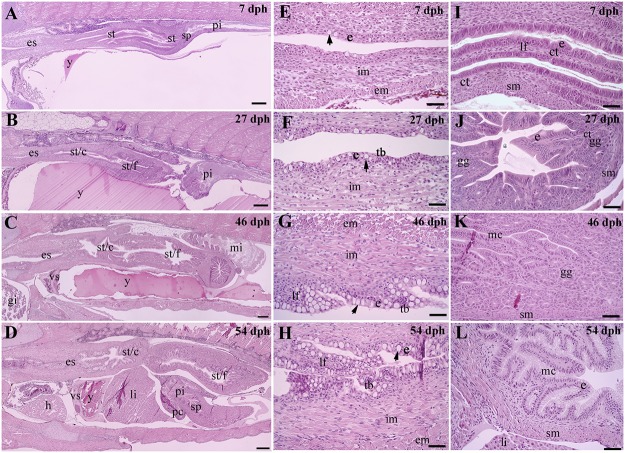
Representative sagittal sections of esophagus and stomach of Atlantic salmon juveniles at various time points (days post hatch [dph]).
(A-D) General overviews of esophagus and stomach at 7, 27, 46, and 54 dph; (E-H) Development of the esophagus: simple epithelium with stratified squamous cells and mucus cells (arrows) at 7 and 27 dph (E and F), presence of taste buds within the epithelium at 27, 46 and 54 dph (F-H), presence of longitudinal mucosal folds at 46 and 54 dph (G and H), and increasing numbers of mucus cells (arrows) and thickness of internal longitudinal and external circular striated muscle over the time; (I-L) Development of the stomach: longitudinal folded mucosal consisting of simple columnar epithelium and connective tissue at 7 dph (I), presence of incipient gastric gland devoid of pepsinogen granules (J), presence of abundant pepsinogen granules in oxynticopeptic cells of gastric glands at 46 dph (K), and cardic glands lined by mucus cells at 54 dph (L). Abbreviations: ct, connective tissue; e, epithelium; em, external circular striated muscle; es, esophagus; gg, gastric gland made up of pepsinogen granule-containing oxynticopeptic cells; h, heart; im, internal longitudinal striated muscle; lf, longitudinal fold; li, liver; mc, mucus cell; mi, mid intestine; pc, pyloric caeca; pi, proximal intestine; sm, smooth muscle; sp, sphincter; st, stomach, st/c, stomach/cardia, st/f, stomach/fundus; tb, taste buds; vs, vitelline syncytium with vitelline veins; y, yolk. Scale bar: (A-L) = 50 μm.